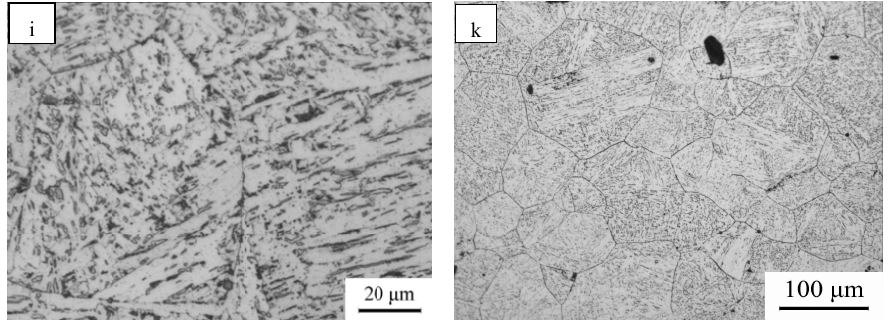
Figure 6. Simulated CGHAZ microstructure/prior austenite grain of the experimental steels: ( a , b ) 18 kJ/cm; ( c , d ) 25 kJ/cm; ( e , f ) 31 kJ/cm; ( g , h ) 44 kJ/cm; and ( i , k ) 81 kJ/cm.